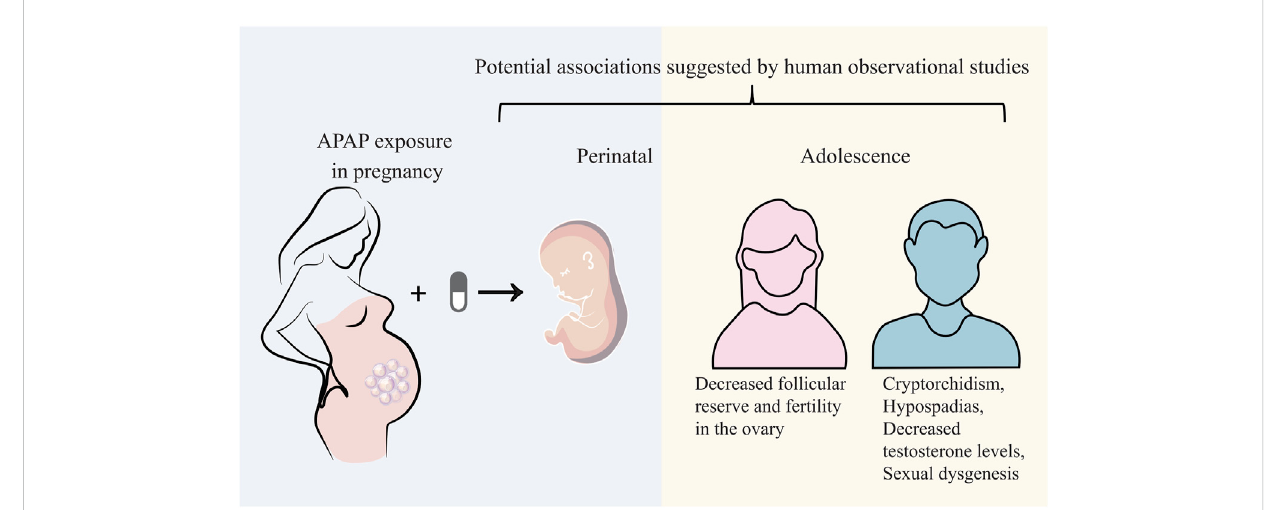
FIGURE 2 Prenatal APAP exposure may potentially disrupt human reproductive functions both male and female offspring.